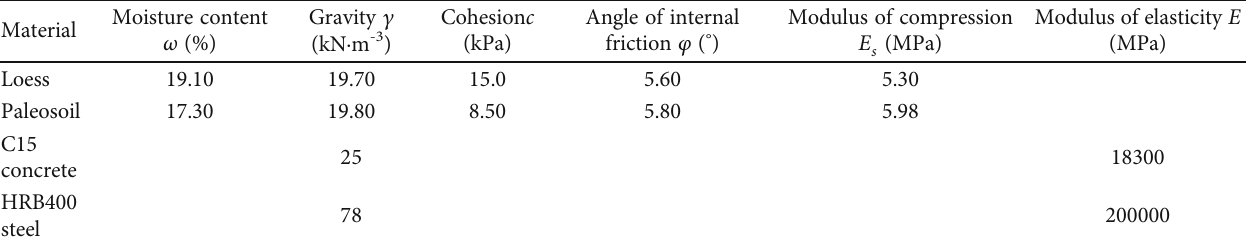
Table 5: Model material parameters.